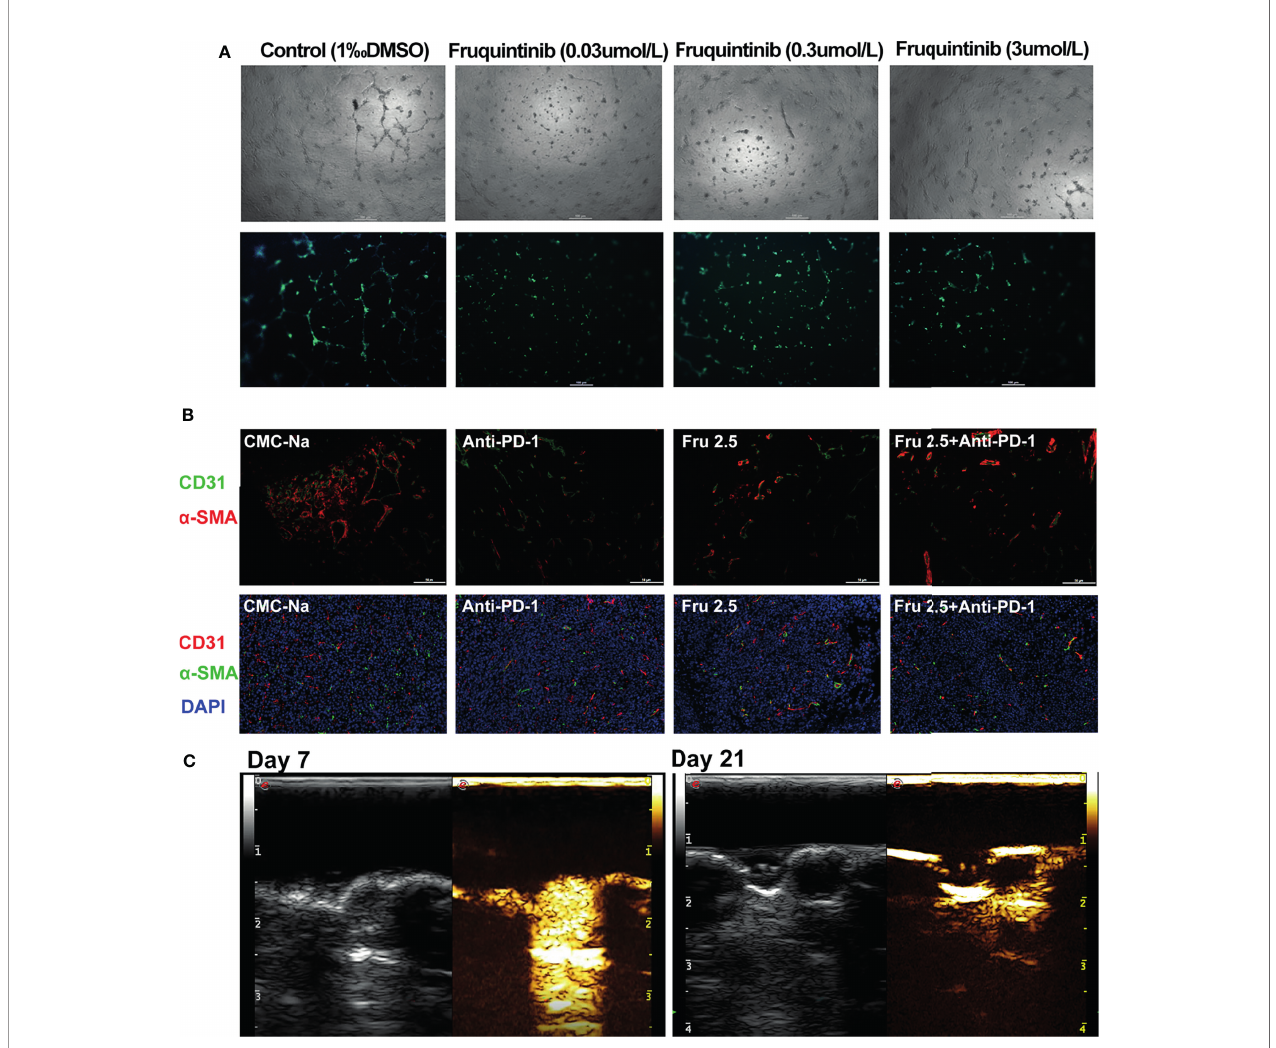
FIGURE 4 | Fruquintinib reduces angiogenesis in CRC both in vitro and in vivo . (A) The effect of fruquintinib on tubular formation in HUVEC in vitro with different doses (0.03,0.3, and 3umol/l) of fruquintinib or CMC-Na control. (B) Representative immuno fl uorescent staining of sections from different treatment groups on day14. Red, CD31; a -SMA staining; green; blue, DAPI staining. (C) Fruquintinib reduces tumor vascular formation in CT26 colon cancer-bearing mice by angiography using ultrasound machine on day 7 and day 21 after